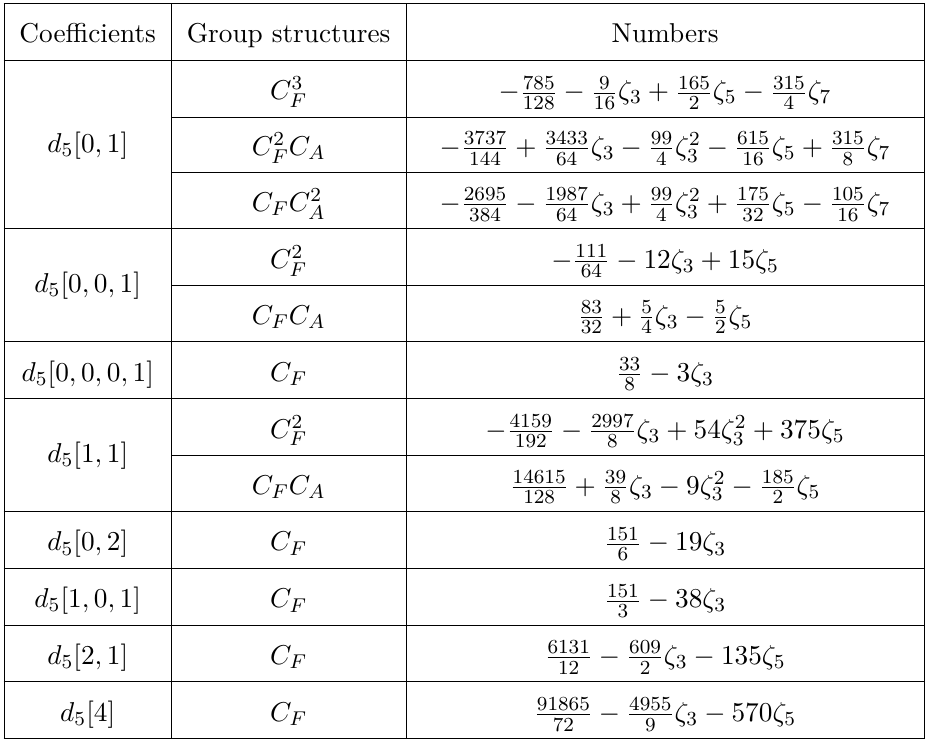
Table 3 . All extracted terms included in the { β } -expansion of coefficient d 5